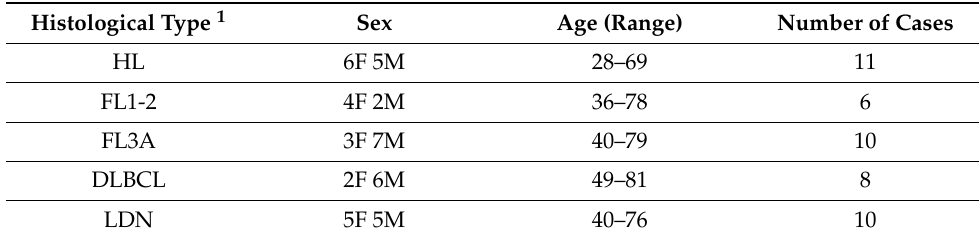
Table 1. Characteristics of lymphomas